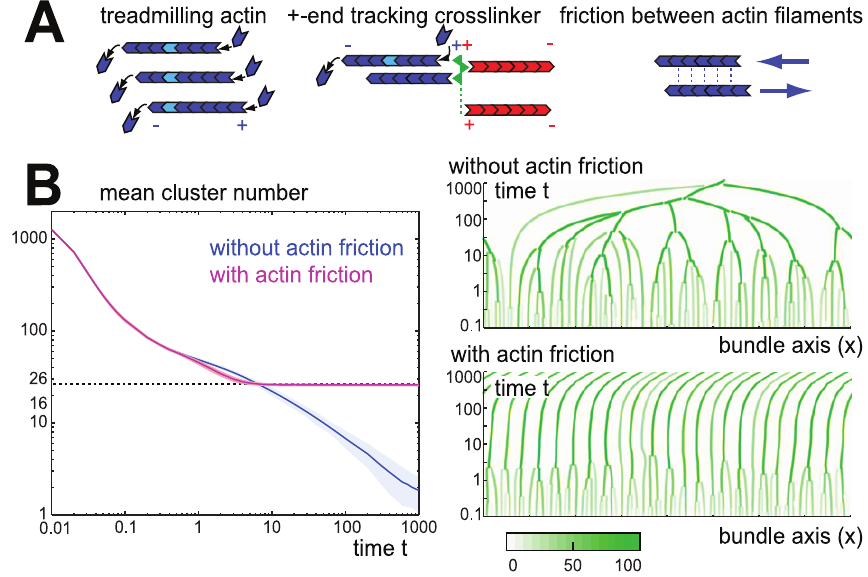
Figure 2. Actin cluster formation and coalescence. A. Our computational model of sarcomeric pattern formation considers a one-dimensional bundle of parallel actin filaments, which undergo treadmilling, i.e. filaments polymerize at their plus-ends and depolymerize at their minus-ends resulting in a net motion of the plus-end with respect to the individual monomers. Plus-end tracking crosslinkers (green) can permanently attach to the plus-ends of actin filaments (blue and red, indicating filament polarity), while still allowing for polymerization at filament plus-ends. B. Plus-end tracking crosslinking results in the formation and coalescence of actin clusters as reflected by a reduction in the number of actin clusters (single actin filaments are counted as one cluster). If there is no friction between sliding filaments ( f ~ 0 ), all actin clusters eventually coalesce into a small number of very large clusters (blue, mean + s.e., n ~ 100 ). Time is measured in units of actin length divided by treadmilling speed, L 0 = v 0 . In the presence of inter-filament friction ( f ~ 0 : 1 c a ), however, actin clusters above a critical size effectively repel each other, resulting in a kinetically stabilized configuration with a finite number of actin clusters (magenta). To the right, example kymographs of actin cluster coalescence are shown for the cases without friction and with friction, respectively. A small imbalance in the number of filaments treadmilling either to the right or to the left within the final striated bundle causes a slow motion of the entire bundle as a whole as is reflected by the tilted cluster trajectories. Using static instead of periodic boundary conditions impedes this motion, see SI text S1. The color scheme encodes filament number in actin clusters as shown in the color bar.